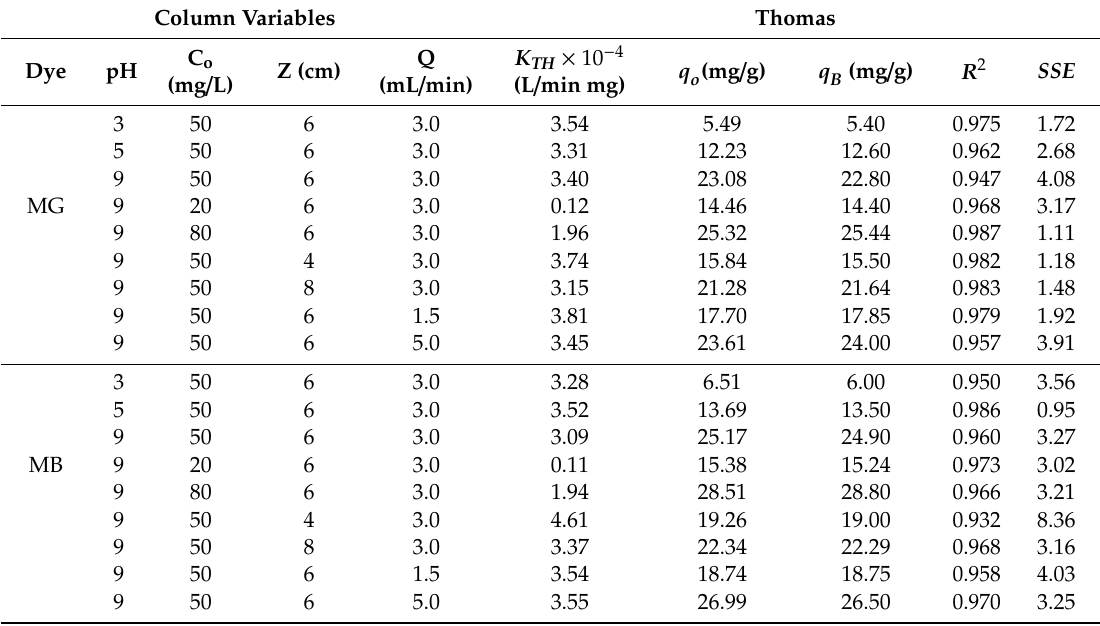
Table 5. Thomas model constants and statistical parameters for MG and MB adsorption by T-PAA at di ff erent column